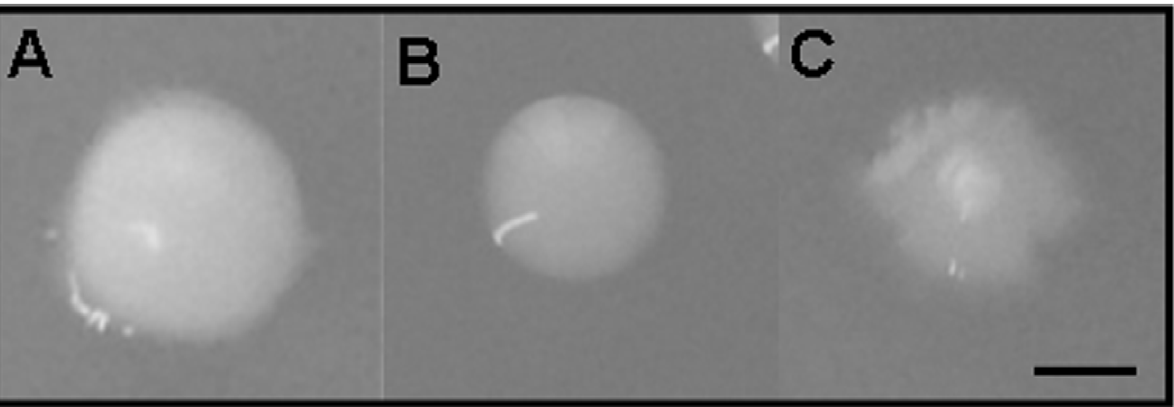
Figure 1. Colony morphotypes of M.avium spp. isolates. Photographs show representative colony morphotypes of MAC isolates grown on 7H11 + OADC plates after 21 days of incubation at 37 u C in 5% CO 2 . A . Smooth, opaque, regular and white morphotype (phenotype observed for all isolates except 2 and 13). B . Smooth, transparent and regular morphotype (phenotype observed for isolates 5, 10, 11, 12, 13 and 104). C. Smooth, transparent and irregular (phenotype observed for isolates 5, 10, 11, 12 and 104). Bar indicates 2 mm. The photographs are representative of N=3.